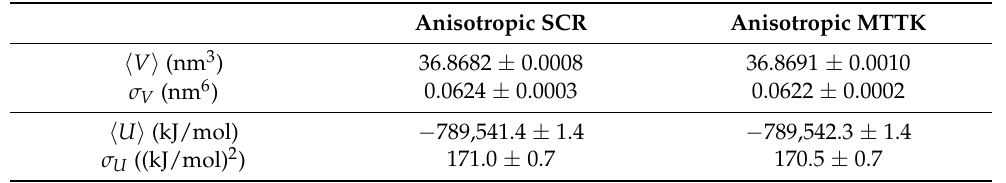
Figure 9. Results from the simulations of the gypsum with LAMMPS, obtained using both stochastic cell rescaling and MTTK algorithms, in their anisotropic variants. Panel ( a ): Autocorrelation functions of the volume. The dashed line reports an exponentially decaying function with time constant β T ,exp Panel ( b ): Autocorrelation function for the series of squared volume displacements from the volume average. The dashed line corresponds to an exponential decay with time constant β T ,exp Table 2. Average and standard deviations of volume and potential energy for the simulated gypsum system, obtained both with anisotropic SCR and anisotropic MTTK barostats. Results were obtained setting τ P = 0.1